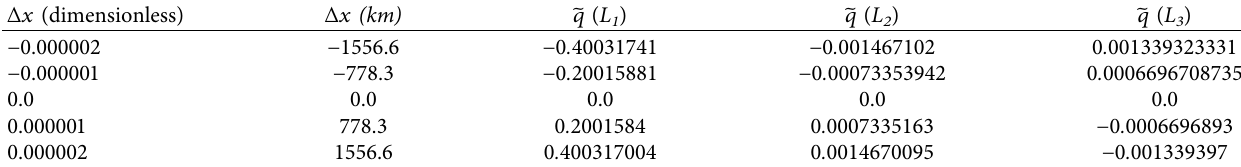
Table 1: The charge per unit mass required to change the liberation poits ∆ x